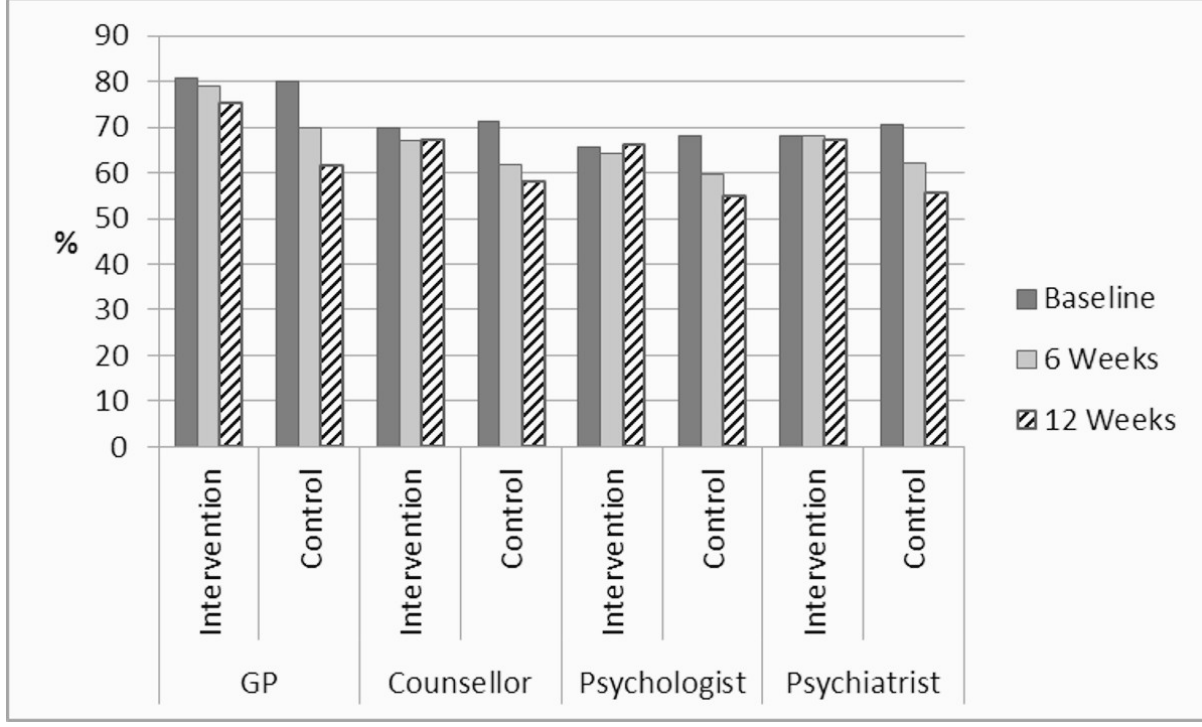
12 weeks n=2196 weeks n=360Baseline n=654Statement